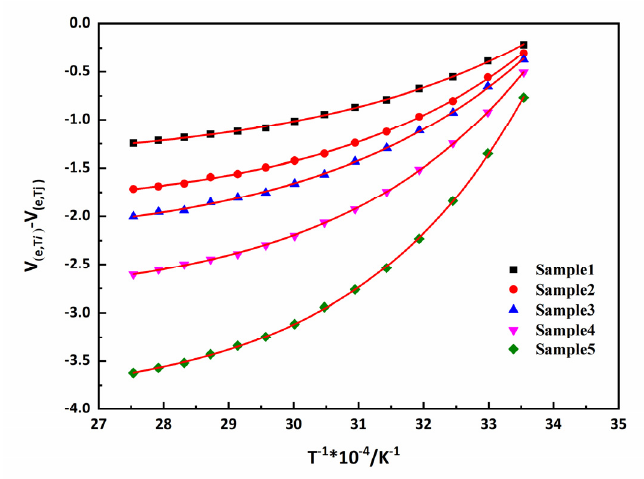
Figure 8. Effective crosslinking density of pseudo-semi IPNs based on Equation (7).